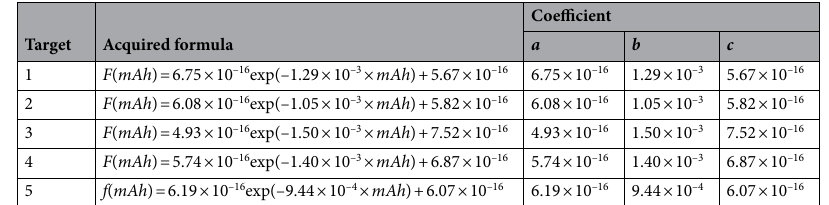
Table 1. Model for the neutron flux in each target sample. mAh is the total number of protons delivered to the target sample. The saturated radioactivity was used as a substitute for the neutron flux.